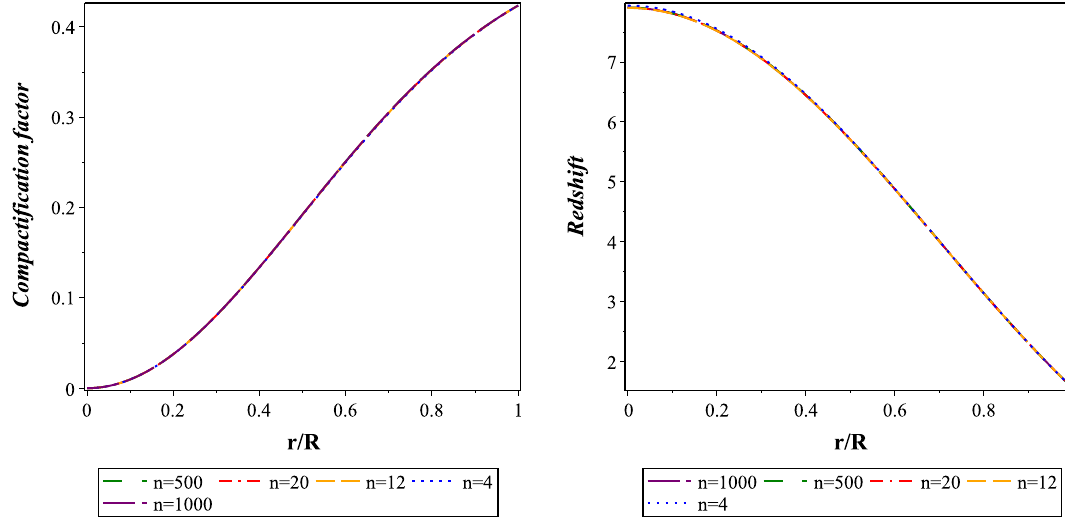
Fig. 5 Variation of the compactification factor m s / r s (left) and redshift z (right) with respect to the radial coordinate ( r / R ). For purpose of plotting this figure , the numerical values of the constants for different parameters n are mentioned in Table